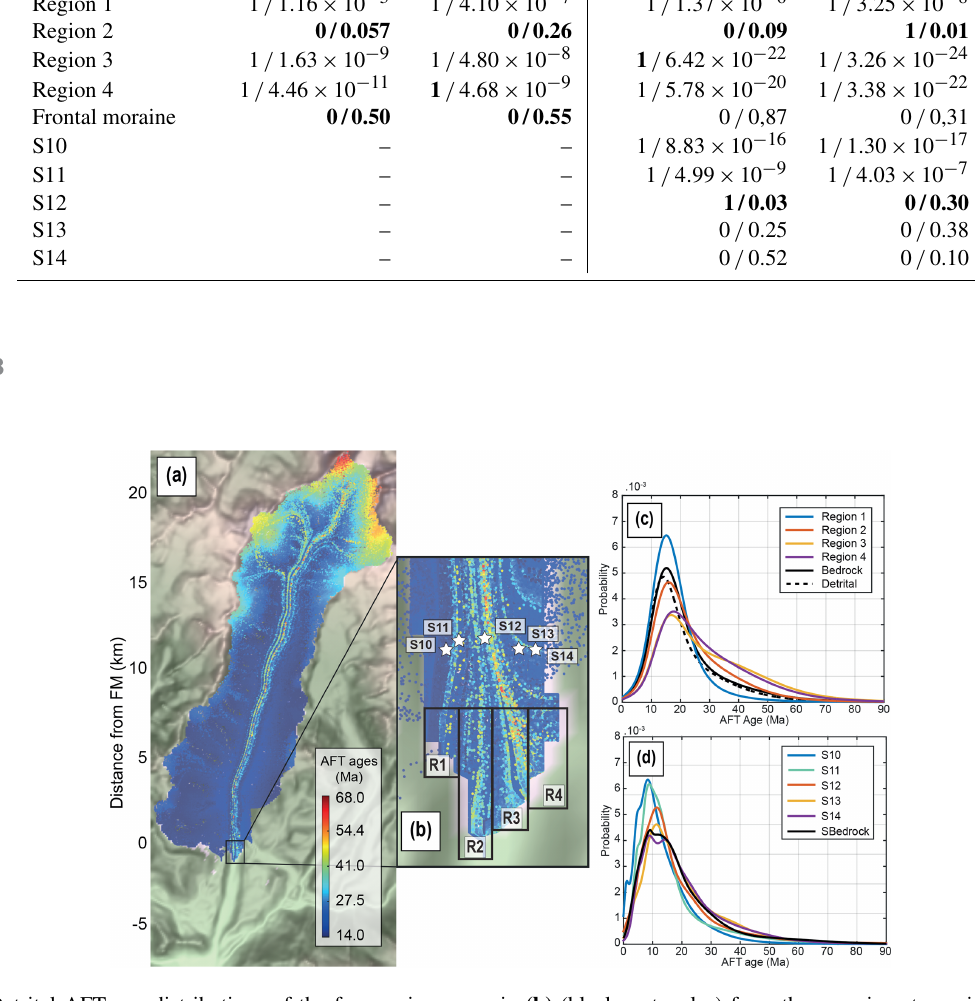
Figure B1. Detrital AFT age distributions of the four regions seen in (b) (black rectangles) from the experiment considering a uniform source of particles (a) . The density plots of modelled detrital AFT ages are shown in (c) . The dashed black line is the mean detrital SPDF for the frontal moraine (FM). The ice-cored detrital SPDFs from Enkelmann and Ehlers (2015) are shown in (d) . Each sample (S10–S14) is located in (b) by the white stars, and the age distributions have been built using the method explained in Sect. 2.4. The bedrock SPDF in (d) results from the bedrock single-grain age distribution presented in Enkelmann and Ehlers